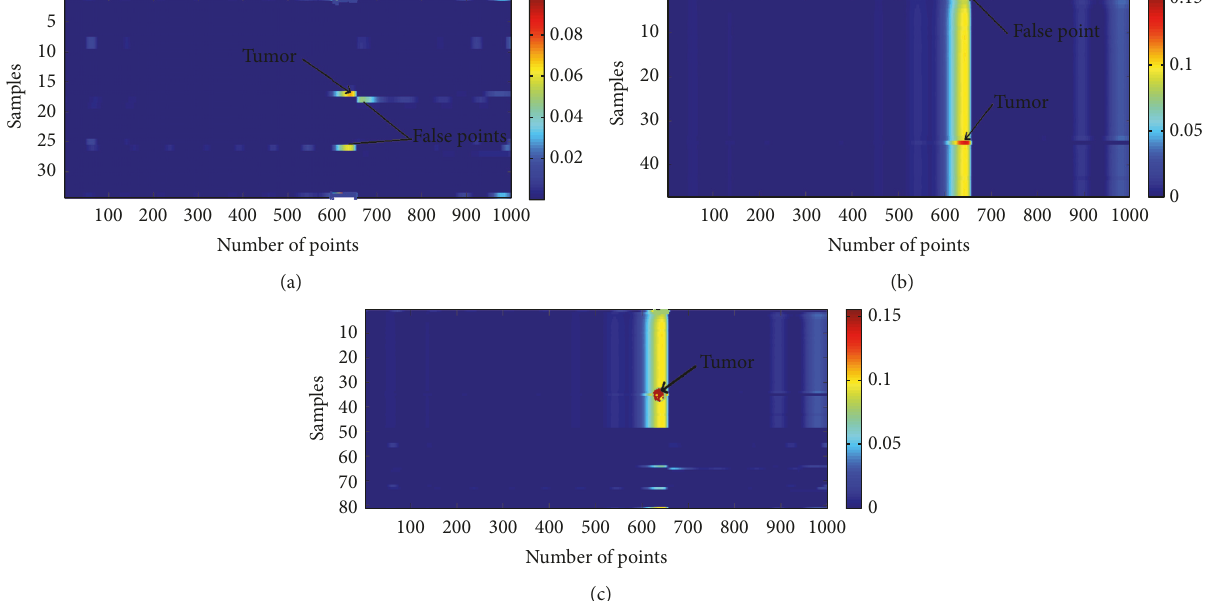
Figure 13: Reconstructed microwave image of tumor by scanning head phantom in (a) 𝑥 - 𝑦 plane, (b) 𝑥 - 𝑧 plane, and (c) 𝑥 - 𝑦 and 𝑥 - 𝑧